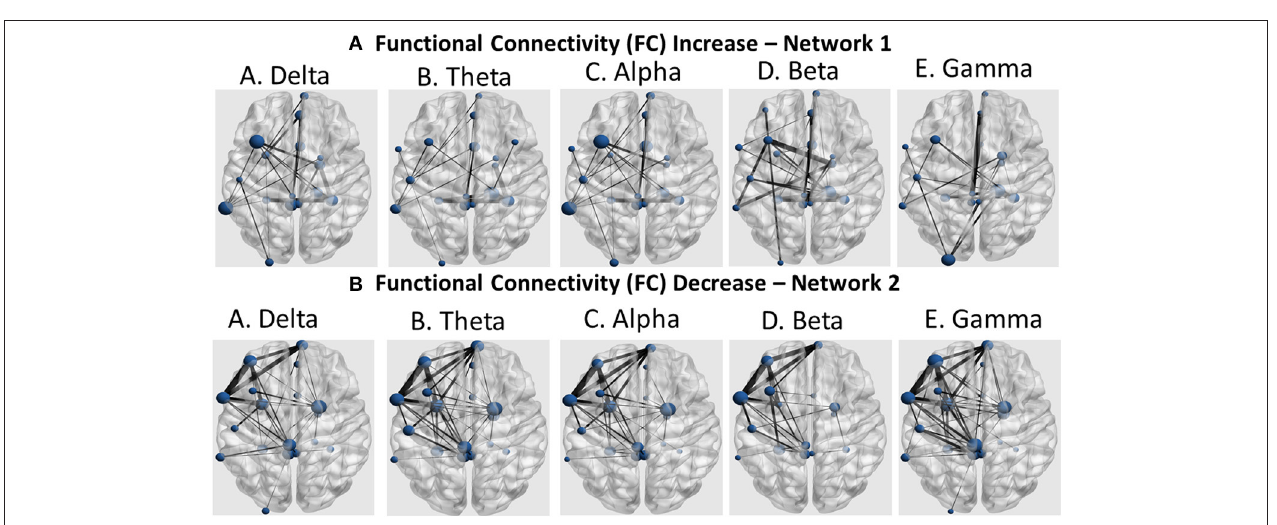
FIGURE 8 | Coronal view of the two subnetworks showing either a functional connectivity linear increase (A) or decrease pattern (B) across the three experimental stages (baseline, 1st and 2nd training periods) for the five cortical rhythms (delta, theta, alpha, beta, and gamma) among the cortical regions identified by the cortical oscillatory analysis. The node size is proportional to its degree, whereas the edge width is proportional to the connectivity magnitude.